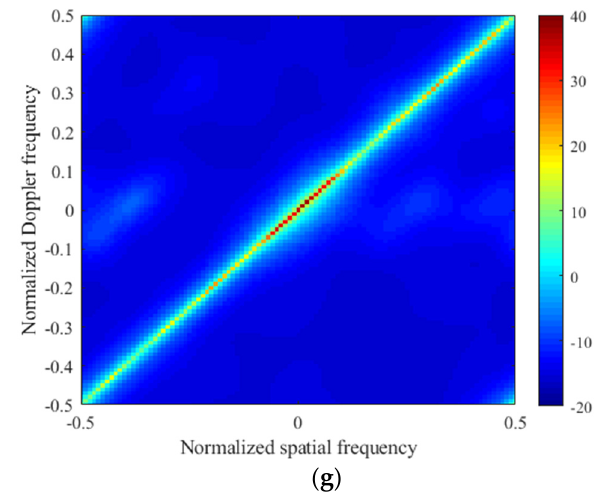
Figure 8. Clutter Capon spectrum with the presence of GP error. ( a ) Ideal CNCM; ( b ) M-OMP; ( c ) M-FOCUSS; ( d ) M-IAA; ( e ) M-SBL; ( f ) M-FCSBL; ( g ) ASDSPL.